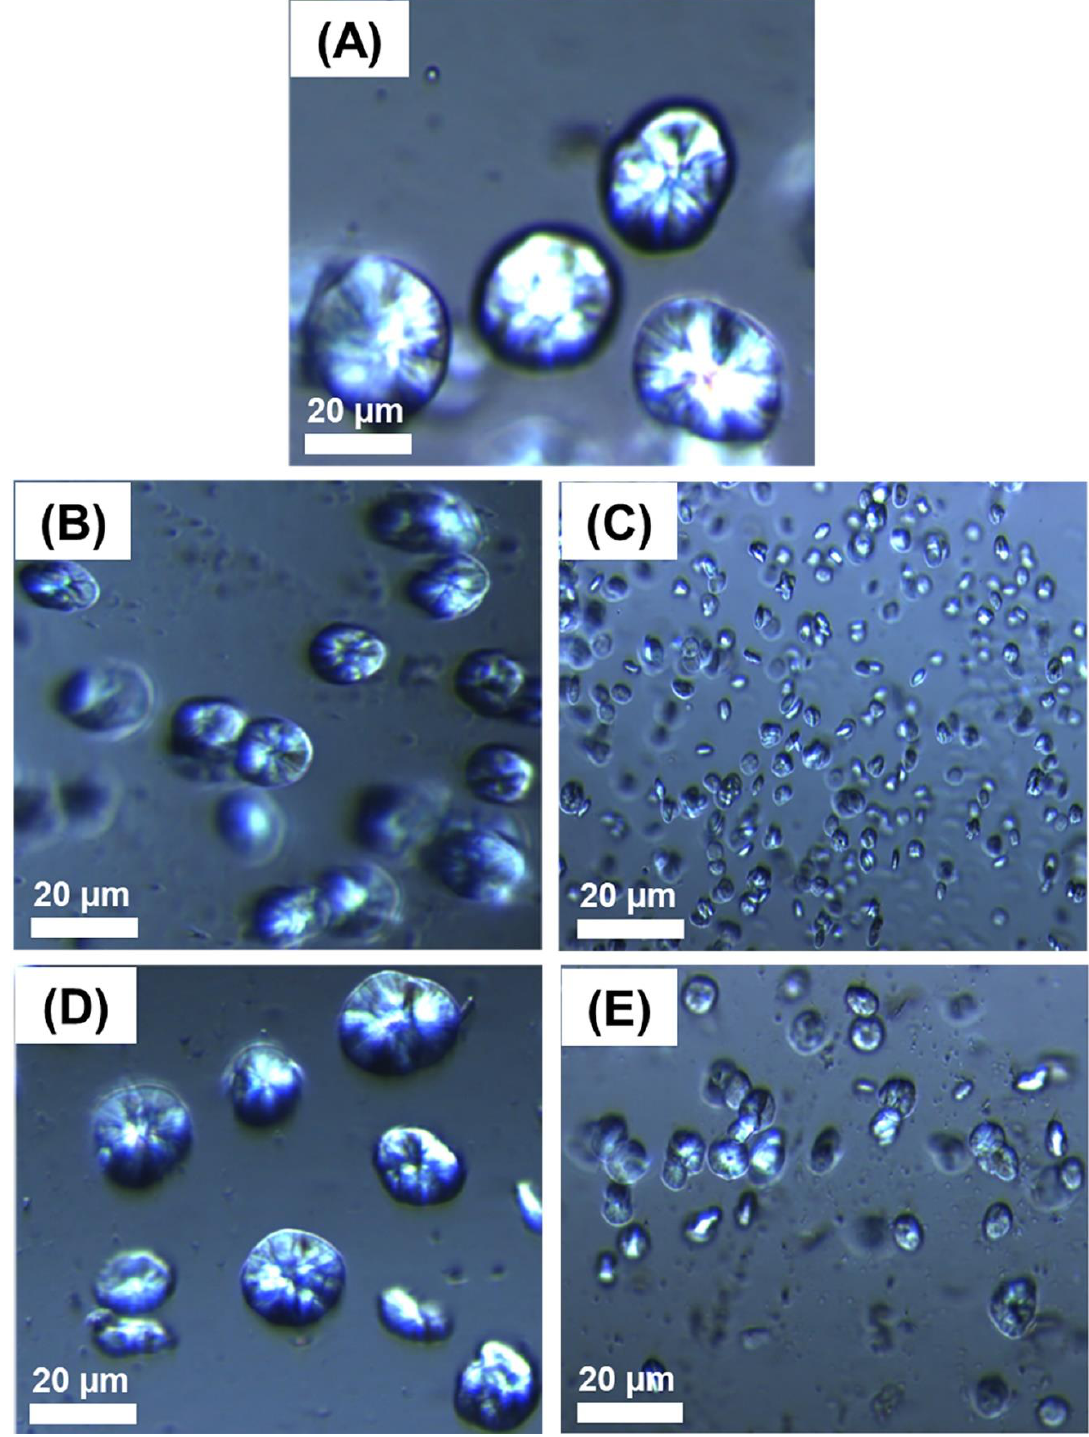
Figure 6. Polarized Light Optical Microscopy (PLOM) micrographs of PE crystal growth in PE90 ( A ), PE90GO2 ( B ), PE90RGO2 ( C ), PE90GO4 ( D ), and PE90RGO4 ( E ).